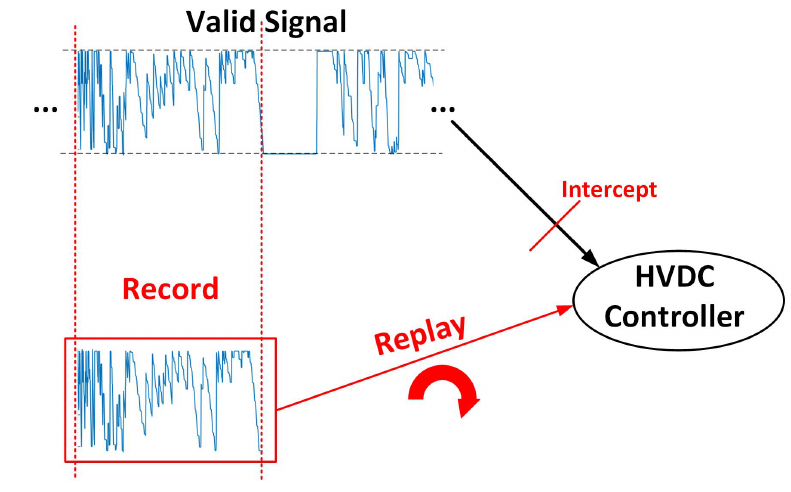
Figure 4. Principle of a replay attack on an HVDC damping